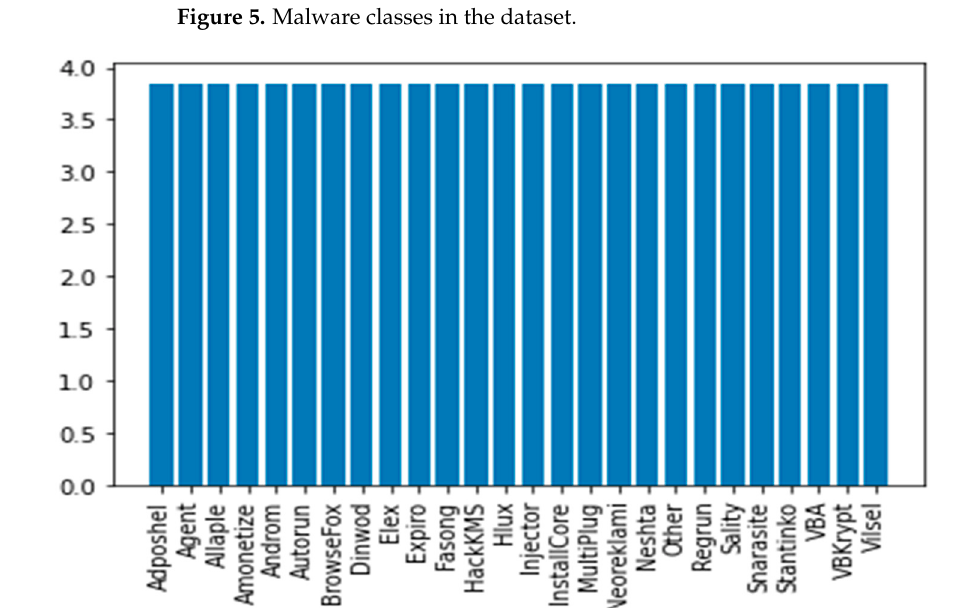
Figure 6. Distribution of samples across various malware classes loaded in the datasets.